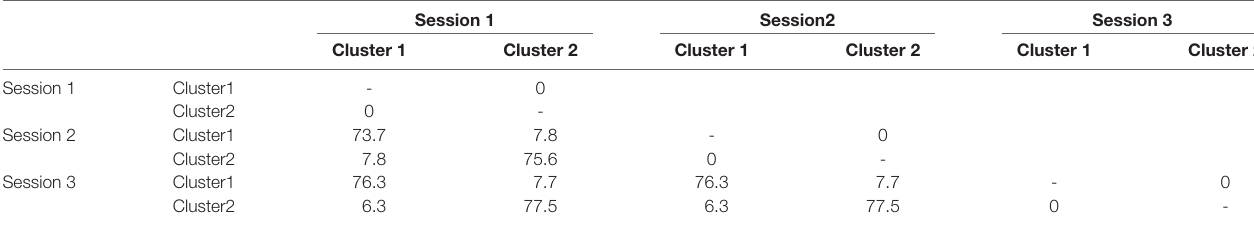
TABLE 1 | Comparisons of the clustering in terms of the Jaccard index (%) for the cluster analysis on EEG powers among the three electroencephalogram (EEG) sessions. Session 1